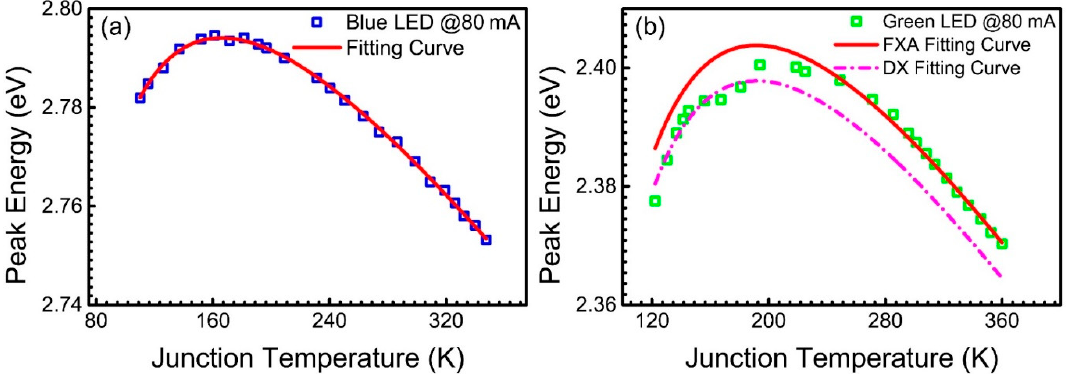
Figure 8. Fitting curves of Varshni’s formula for ( a ) blue LED and ( b ) green LED at 80